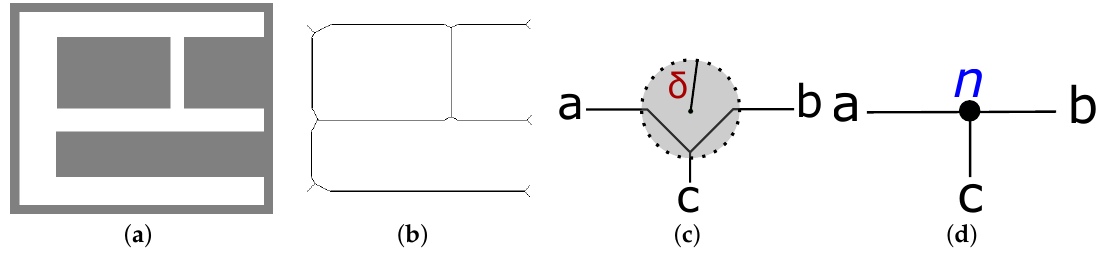
Figure 6. T-node map generation. ( a ) Binary grid-map. ( b ) Skeleton map. ( c ) Clustering within δ distance. ( d ) Clustered node n